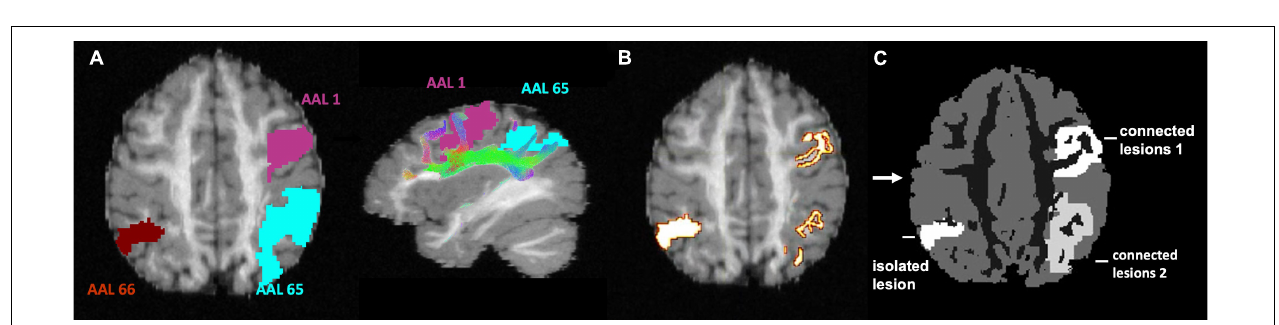
FIGURE 5 | Lesion phantom simulation. (A) AAL1 and AAL65 are highly connected regions; ALL66 is not connected to either AAL1 or AAL65. (B) The endpoints of ground-truth white matter tracks connecting AAL1 and AAL65 regions are extracted. The entire AAL66 region is used to create an isolated lesion. (C) The selected endpoints in AAL1 and AAL65 were dilated to form uniform high-intensity lesions, which were added to segmented T1 data to form a phantom image for PET simulation. This image was also used as the ground-truth for method